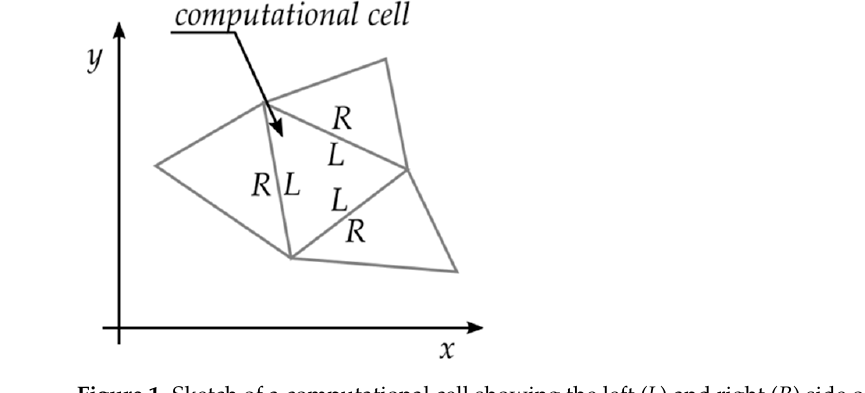
Figure 1. Sketch of a computational cell showing the left ( L ) and right ( R ) side of each edge. The boundary conditions for the system of equation Equation (6), considering water, are the standard ones usually included in hydrodynamic models (e.g., water stage or discharge hydrograph, rating curve, Froude number hydrograph [34]). Regarding wood, a wood mass hydrograph can be set as upstream boundary condi- tion while a simplified condition is proposed for the downstream boundary. The wood concentration at the right side of a boundary edge ( ϕ R ) is set equal to the total wood concentration of the computational cell, so that the average value computed for calculation (Equation (11)) depends only on the difference between the left and right water depth. Since, for boundary edges, the right water depth h R is calculated from the downstream boundary conditions, the wood mass follows the variations of the water depth that are related to the selected